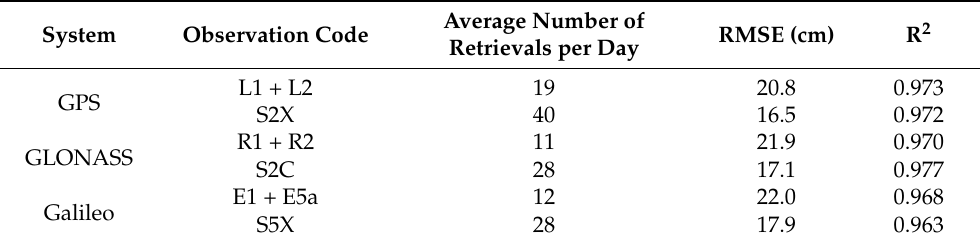
Figure 12. Performance of sea surface height with different GNSS observations for site SC02. ( a – c ): Linear relationship of sea-level variations estimated from GNSS PE arcs versus the in situ results recorded by tide gauge; ( d – f ): Van de Casteele diagrams (GNSS-estimated sea-level residuals versus in situ measurements). Table 4. The average number of retrieval points per day, RMSE, and correlation coefficients (R 2 ) for each observation type at site SC02.